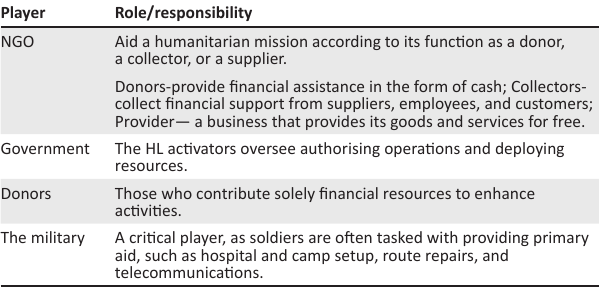
TABLE 1: The summary of players in humanitarian logistics and their